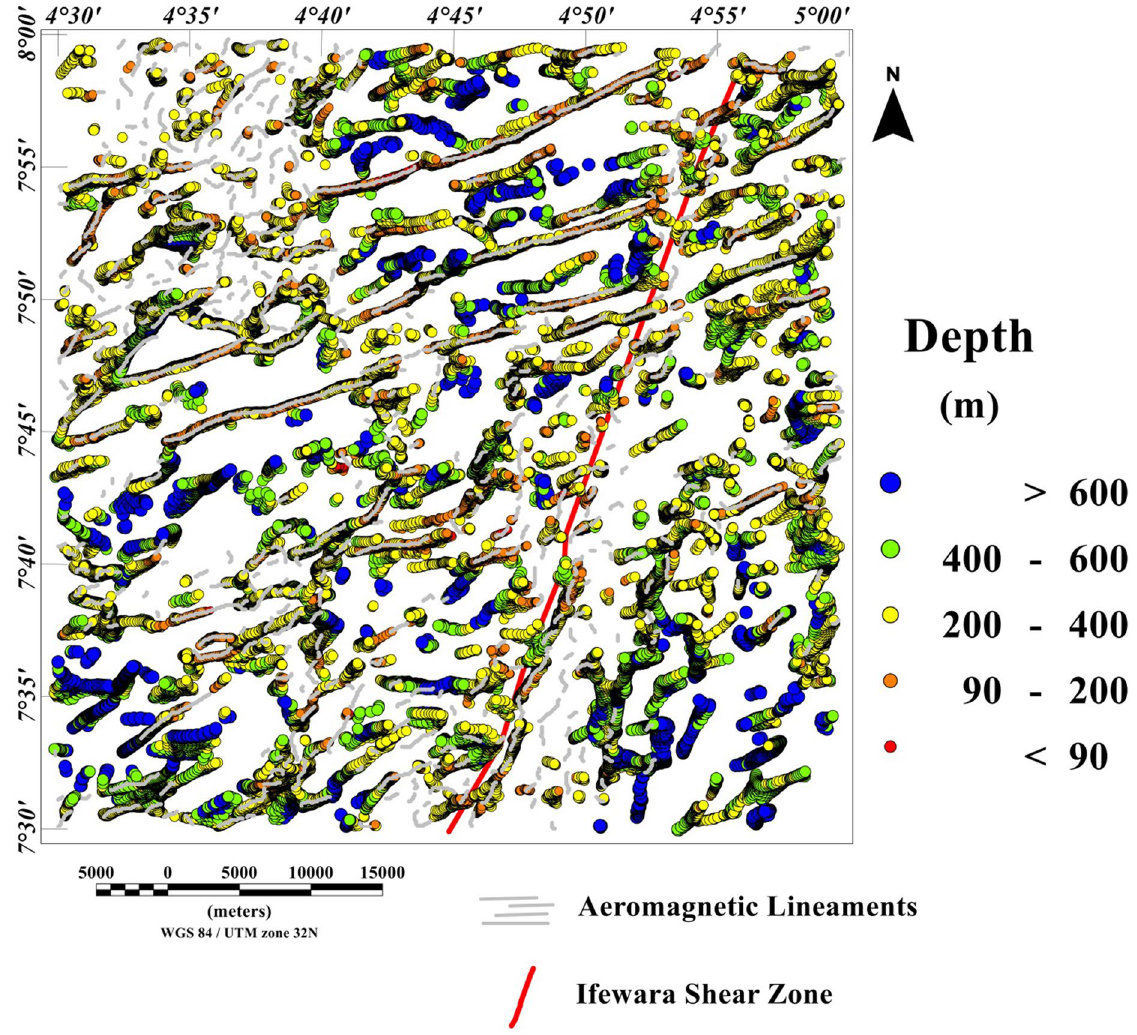
Figure 11. 3-D Euler deconvolution map with superimposed lineaments delineated from TGA method, revealing good correlation of TGA lineaments with 3-D Euler depth